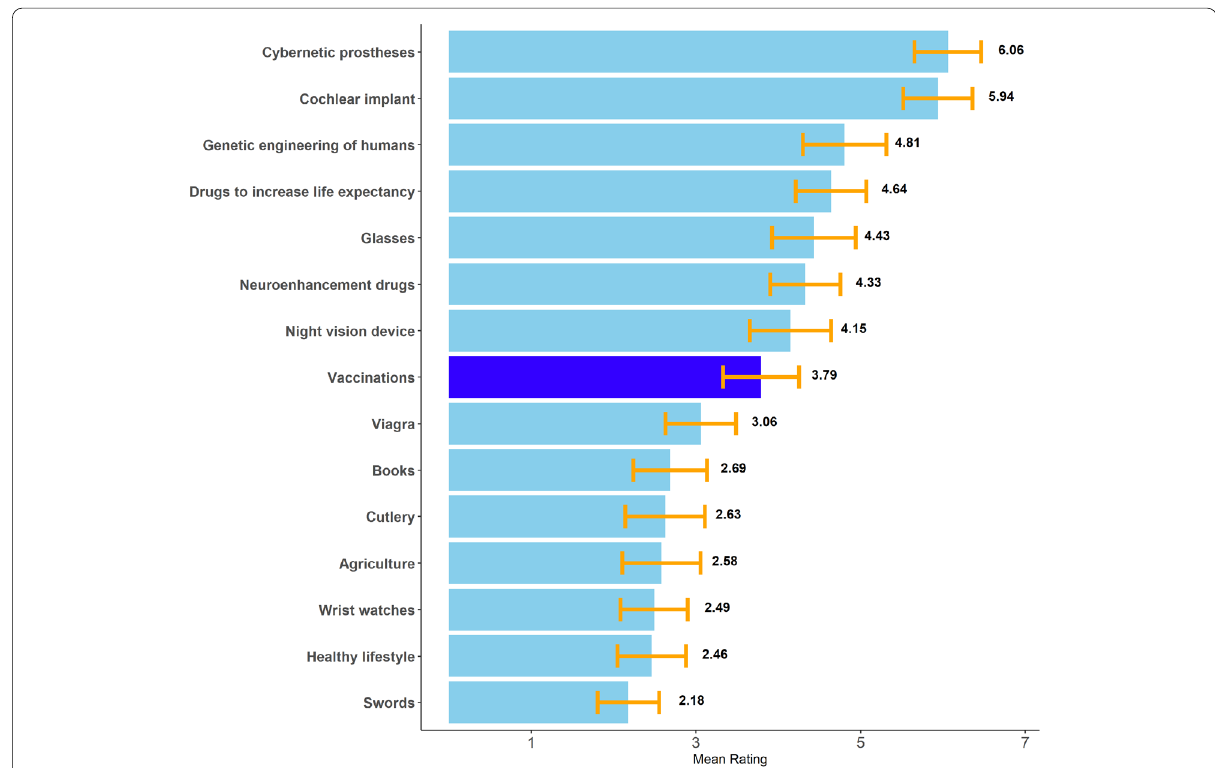
Fig. 1 Ratings on the Prestented Examples. Orange bars represent